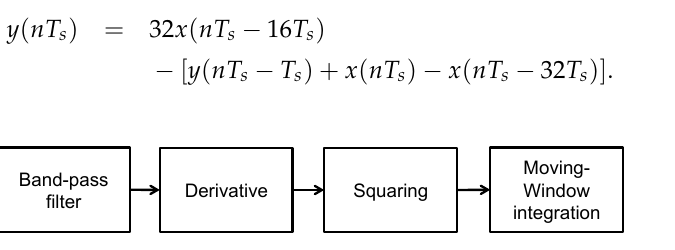
Figure 4. Process of the Pan–Tompkins